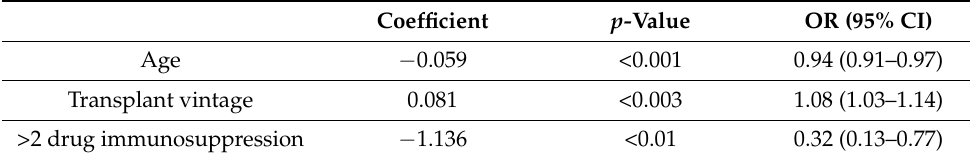
Table 3. Multivariable logistic regression analysis of factors affecting anti-s